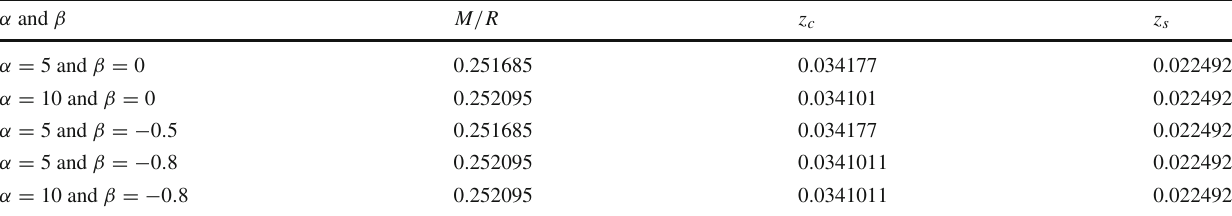
Table 1 Physical parameters of the MGD solution for 0 . 000341km − 2 , with different coupling parameters α and β corresponding solution A